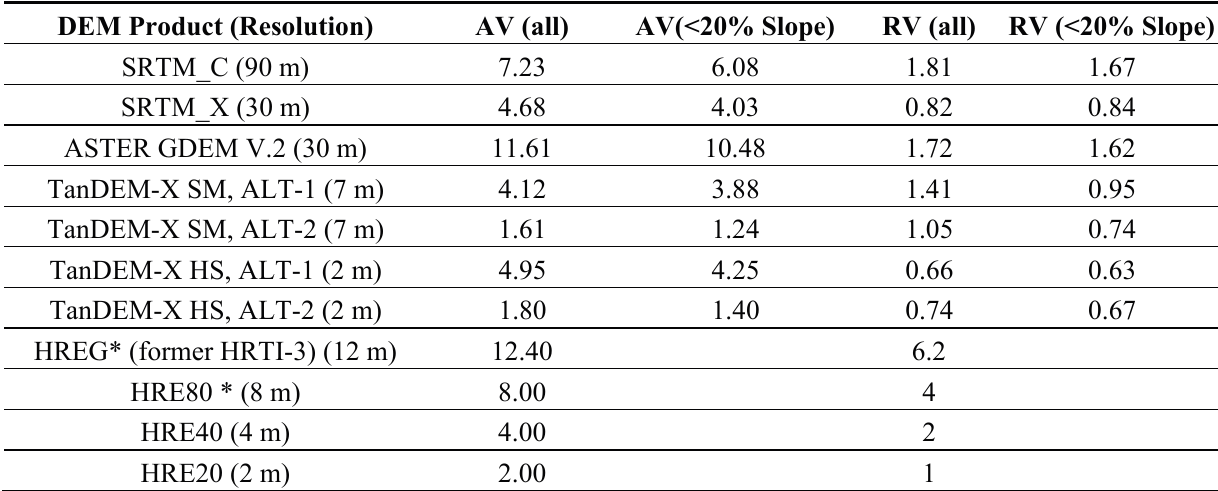
Table 2. Mean absolute vertical accuracy ( AV in m) and relative vertical accuracy ( RV in m) of all evaluated DEM products compared to the RTK-GPS field survey. The values in brackets indicate the resampled resolution of the final DEM